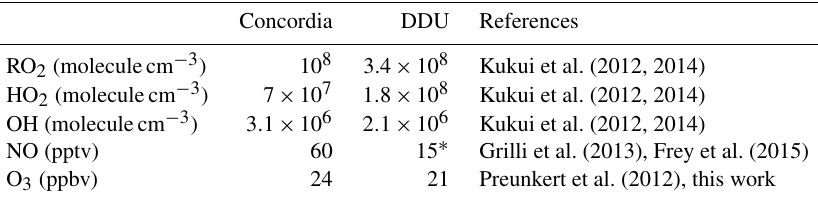
Table 1. Chemical measurements available from Concordia and Dumont d’Urville gained during the OPALE campaigns (in 2010–2011 at DDU, in 2011–2012 at Concordia) that were used to calculate production and losses of ozone reported in Fig. 7 (see Sect. 3.1.2). Values are 24h averages.